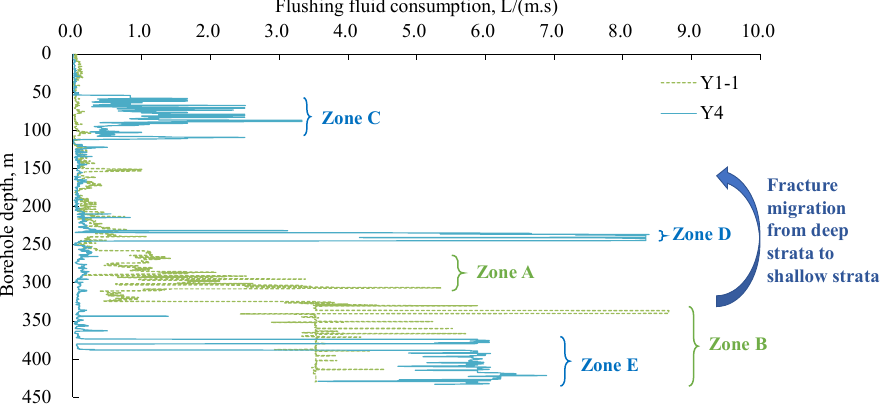
Figure 10. Comparison of flushing fluid leakage during the drilling process at No. Y1-1 and the Y4